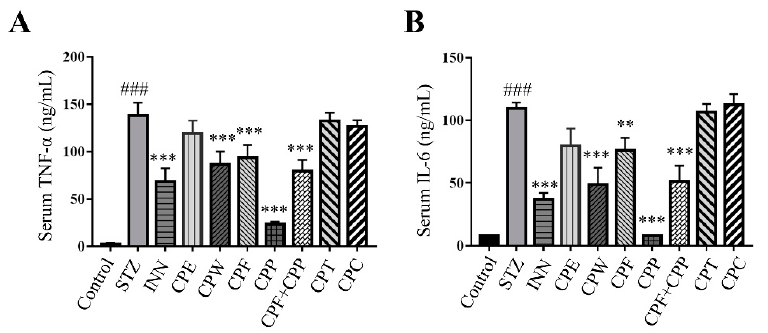
Figure 4. CPF (flavonoids fraction from C. paliurus leaves) and CPP (polysaccharide fraction from C. paliurus leaves) suppressed inflammatory cytokine levels in STZ (streptozotocin)-induced dia-